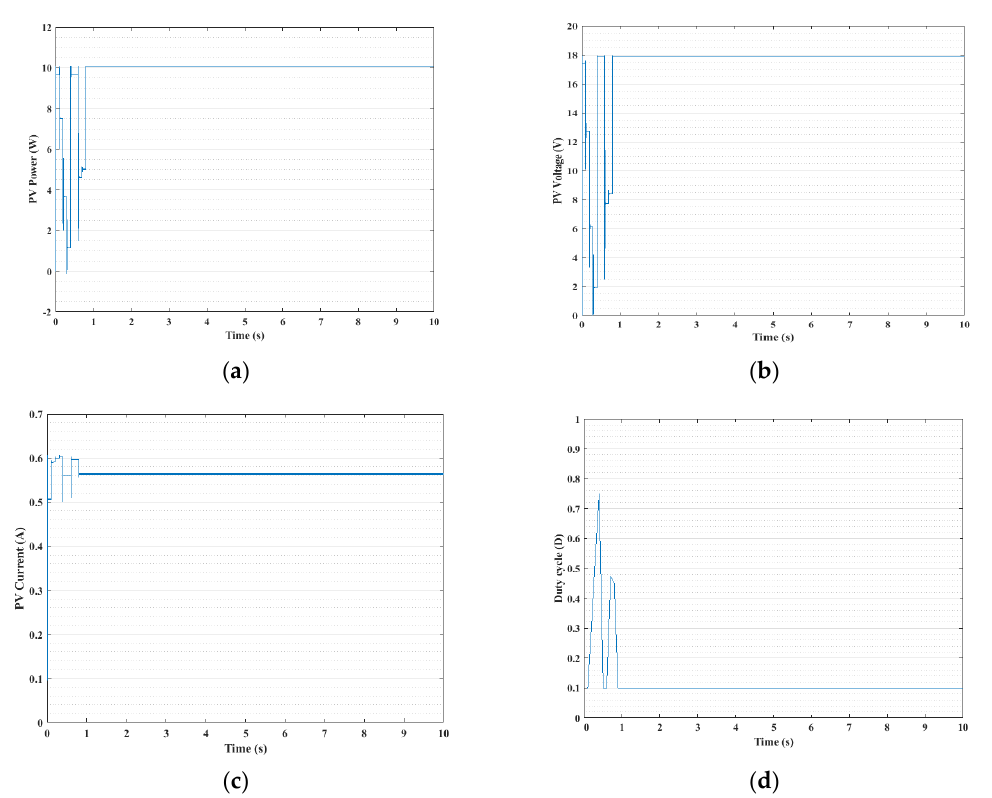
Figure 12. Modified LFO at 200 W/m 2 irradiance. ( a ) power ( b ) voltage ( c ) current ( d ) duty cycle.